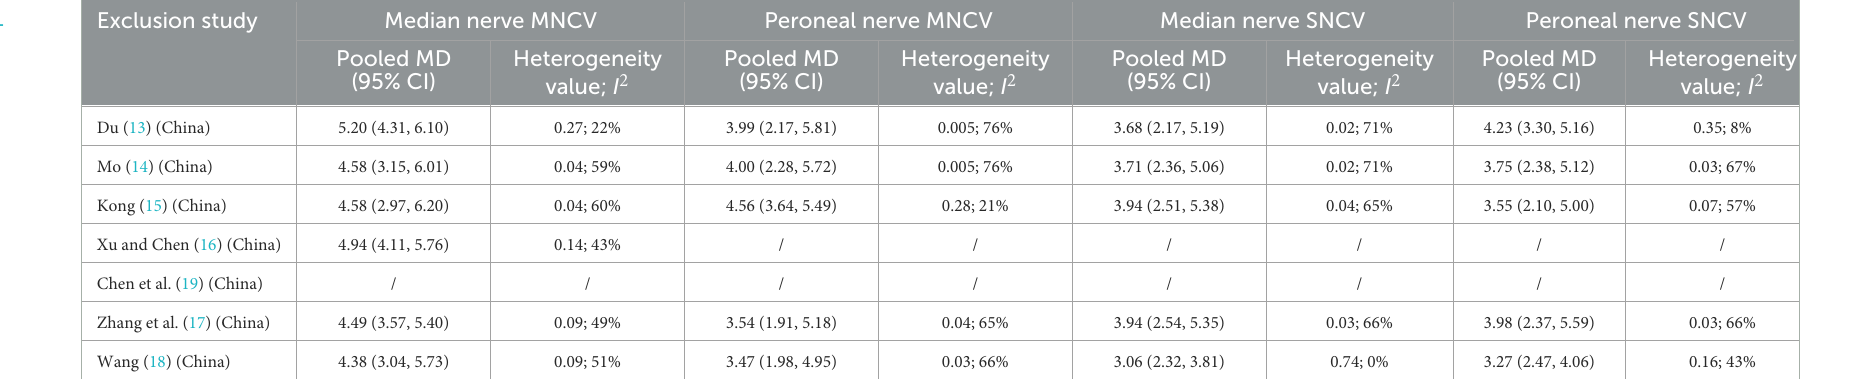
TABLE 4 Heterogeneity and MD in sensitivity analysis of outcome indicators.